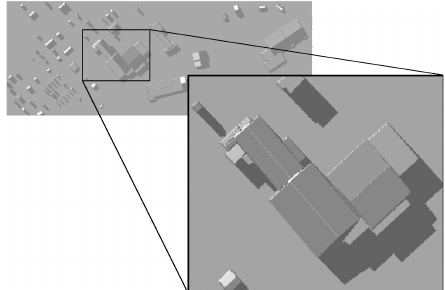
Figure 10: The houses extracted by the proposed method. (Courtesy of Zhou et al.